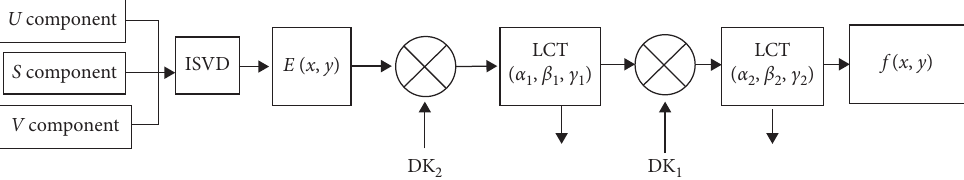
Figure 4: Flow chart for decryption scheme.